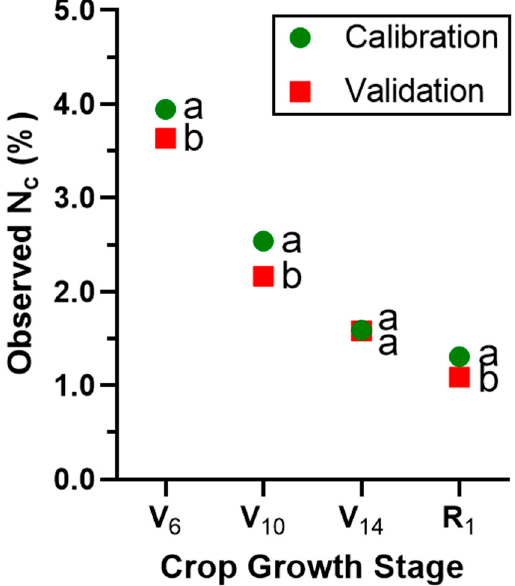
Figure 4. Plant nitrogen concentration (Nc) in the calibration and validation datasets according to crop growth stage (for green circle, n = 90 and for red squares, n = 75). Means of Nc followed by the same letter within a growth stage are not significantly different by LSD test ( p < 0.05).